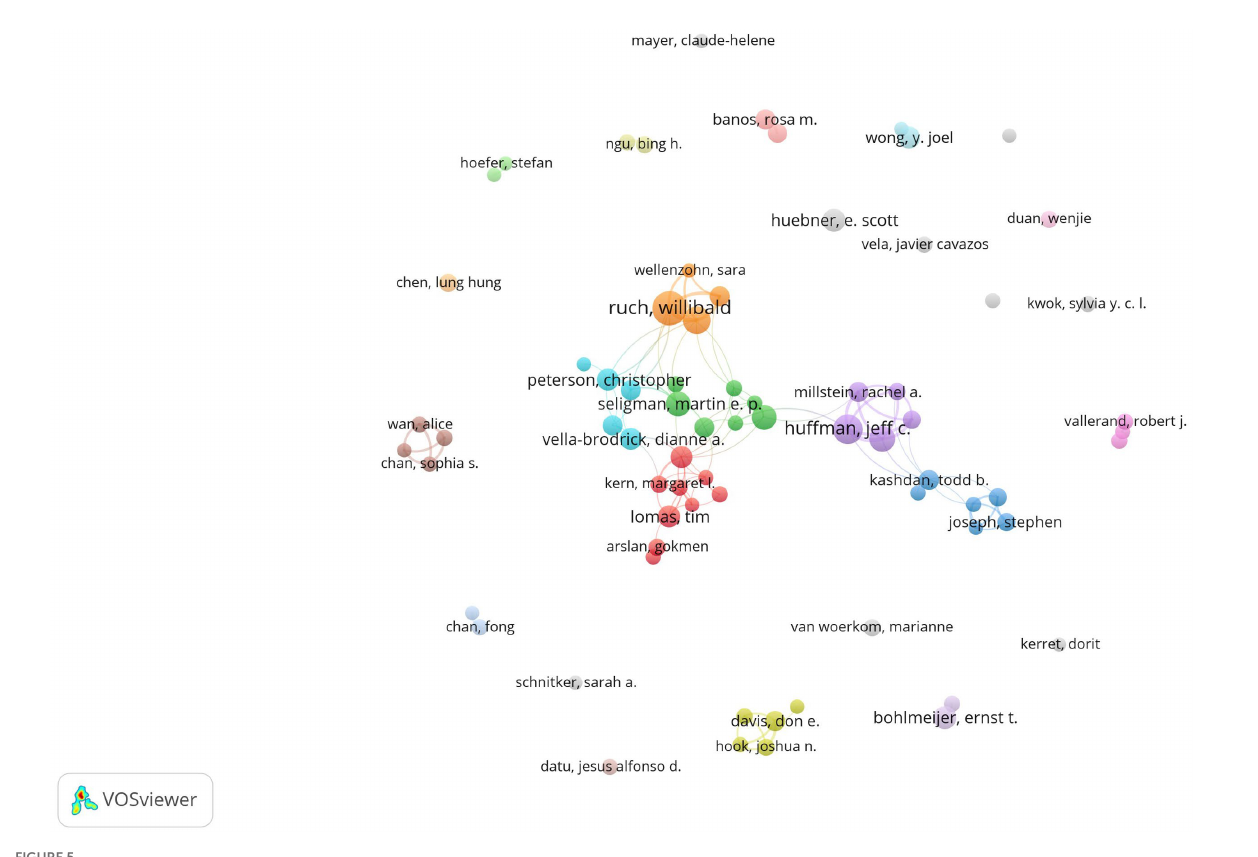
FIGURE 5 The authors’ map of positive psychology research.